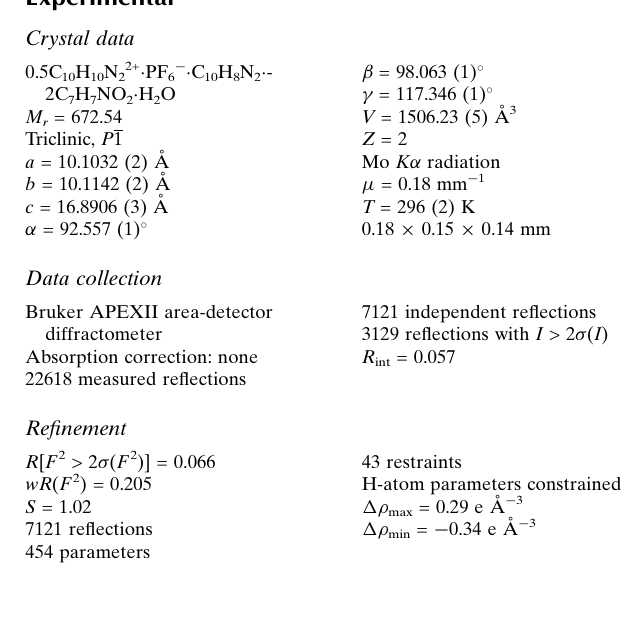
Hydrogen-bond geometry (A˚ , (cid:3)